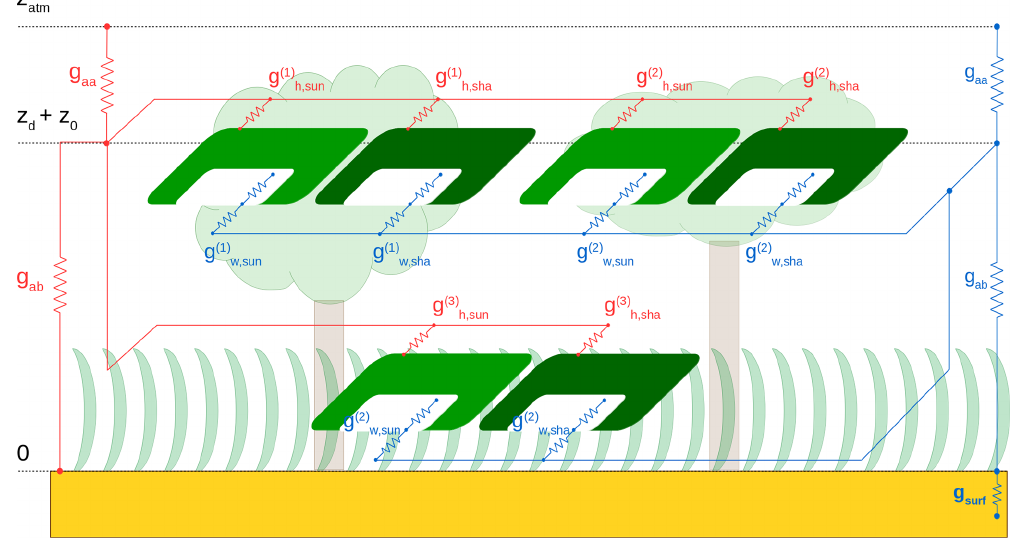
Figure 2. Networks of sensible (red) and latent (blue) heat exchange between the ground surface, the canopy, and the atmosphere in the patch. Light green indicates the sunlit fraction of the cohorts, dark green the shaded fraction. g aa is the aerodynamic conductance from the canopy air to the atmospheric reference level ( z atm ). z 0 and z d are, respectively, roughness length and zero plane displacement. g ab is the aerodynamic conductance for heat/moisture flux from the ground surface to the canopy air. g surf is the surface conductance for moisture flux. g (i) is the conductance for sensible heat transport from the sunlit (shaded) part of cohort i to the canopy air. g (i) moisture transport from the sunlit (shaded) part of cohort i to the canopy air, with the contributions from stomatal conductance and leaf boundary layer conductance represented explicitly. A dry canopy ( f wet = 0) is represented for